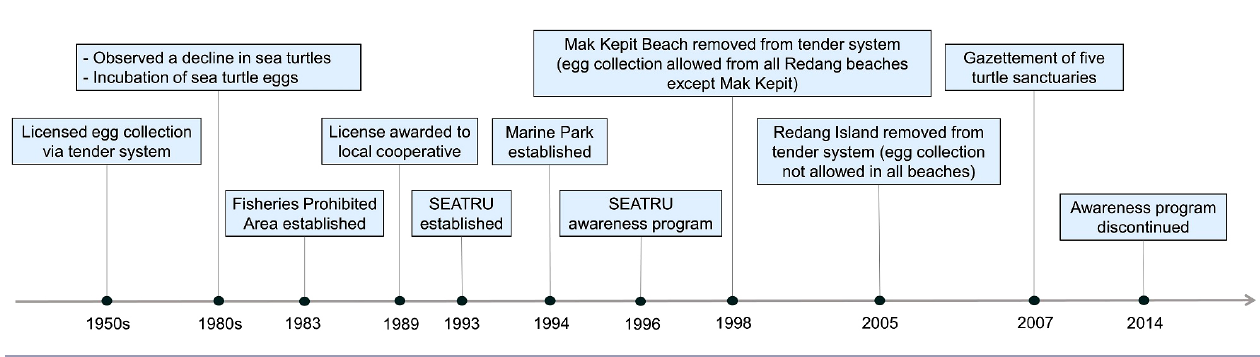
Fig. 1 . Timeline indicating the sea turtle conservation history of Redang Island. Licensed egg collection was initiated by the Terengganu State government in the 1950s. A Fisheries Prohibited Area was established in 1983. Licensed egg collection was offered to the local cooperative in 1989. Conservation efforts to incubate turtle eggs also began in the 1980s. Because of the severe decline in sea turtles in Redang, the Sea Turtle Research Unit (SEATRU) was set up in 1993. In 1994, Redang Island and the surrounding islets were gazetted as a Marine Park. In 1996, SEATRU initiated an awareness program for Redang school children that continued for 18 years. Mak Kepit beach was removed from the tender system in 1998. In 2005, the tender system was fully abolished for all beaches on Redang Island. In 2007, the five main nesting beaches in Redang Island were gazetted as